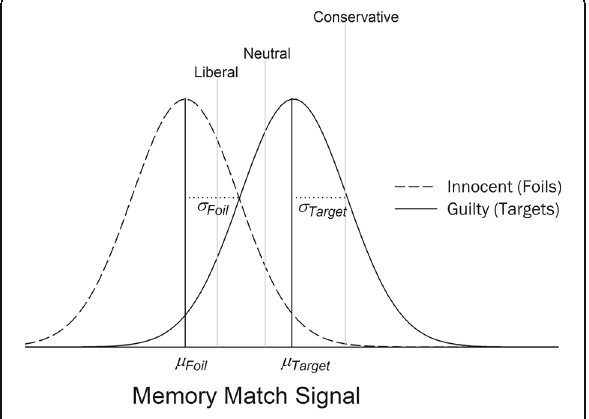
Fig. 3 An equal-variance Gaussian signal detection model illustrating the placement of three different decision criteria (liberal, neutral and